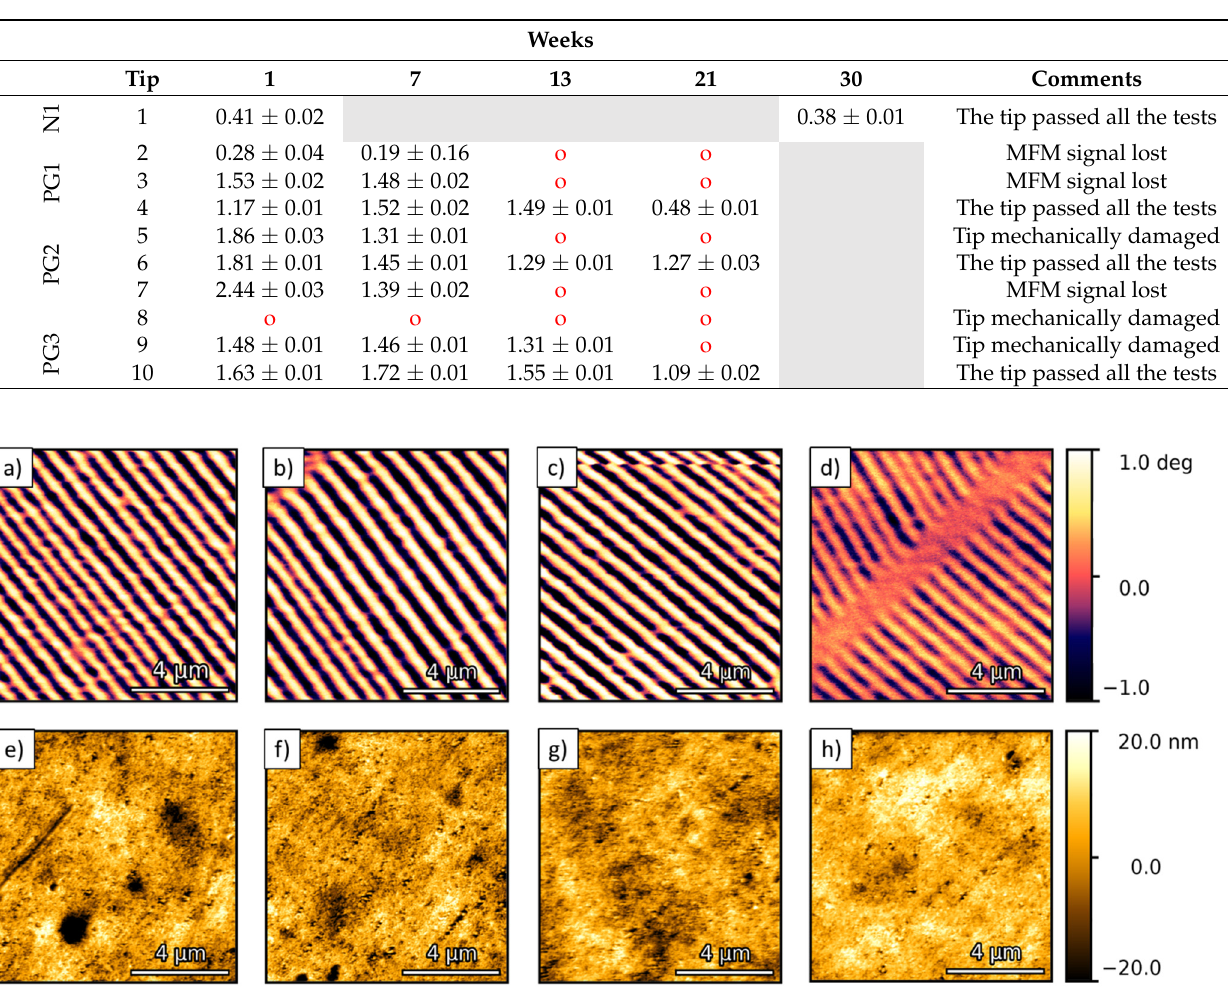
Table 2. Evolution of the magnetic contrast (in deg, as explained in the text) over time for the tested FEBID magnetic tips. Tip 1 was studied the first week, stored for 30 weeks, and then measured again at the end of the test. The red circles represent tests in which no results were obtained due to mechanical damage of the tip or loss of the magnetic signal, as noted in the Comments column. It is worth mentioning that the tips were not externally magnetized at any time.